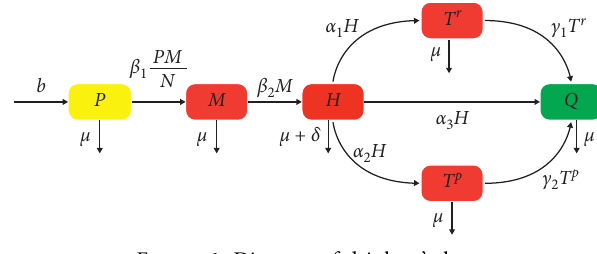
Figure 1: Diagram of drinkers’